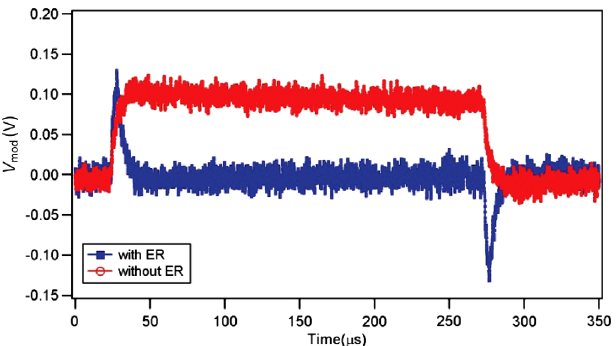
FIG. 19. Forward power drive signal for an SRF cavity with 250 μ sec-duration tune beam with single beam (red) and a two- beam, energy recovering setup (blue) (from